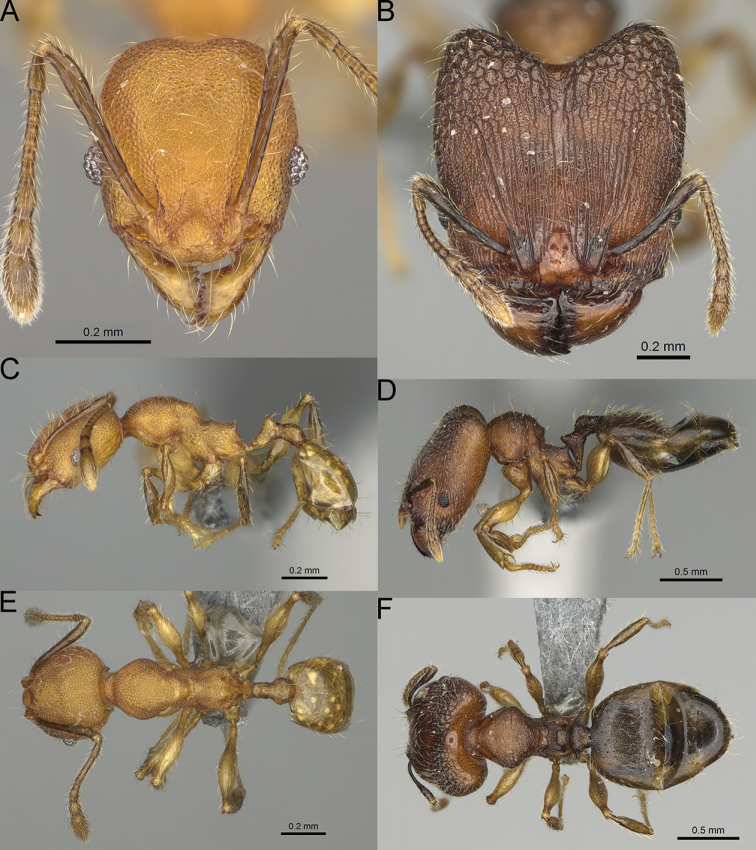
Pheidole
binara sp. nov., full-face view (A), profile (C), and dorsal view (E) of paratype minor worker (CASENT0923182) and full-face view (B), profile (D), and dorsal view (F) of holotype major worker (CASENT0353299).